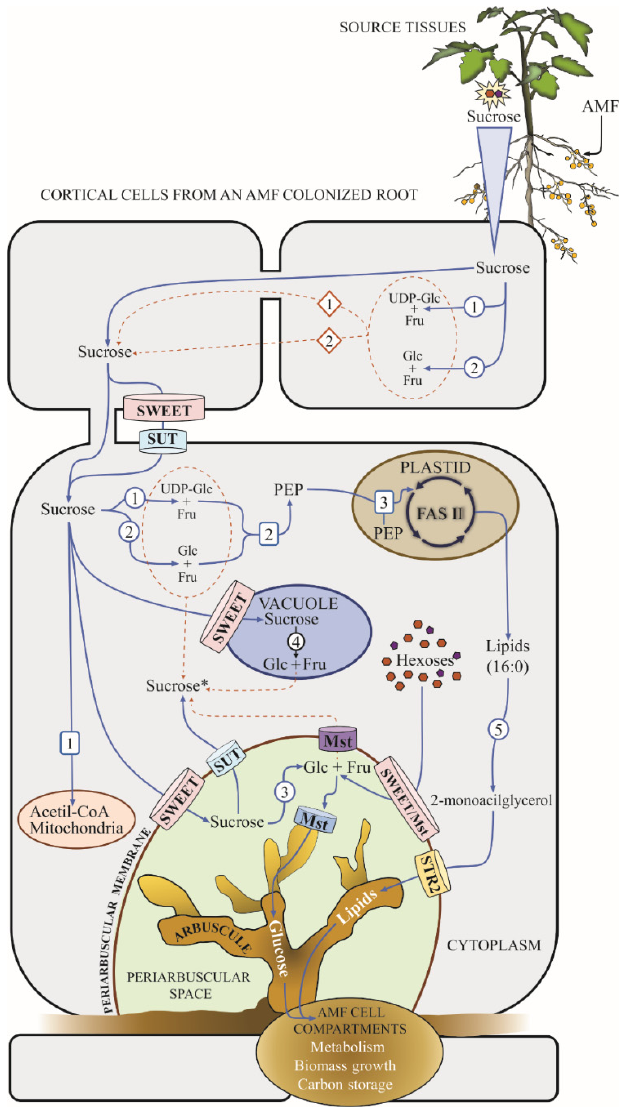
Figure 2. Carbon flux to the cortical root cells during arbuscular–mycorrhizal interactions. Photosynthates flow through the mycorrhizal plant from the leaves to the arbusculated cortical cells in the roots. The catabolism of Suc in the arbusculated and other cortical cells close to them promotes Suc mass flow and enables the translocation of hexoses, Suc, and lipids to the periarbuscular space towards the fungal arbuscule, imposing a carbon sink (Updated from Wipf et al., 2019; Roth and Paszkowski, 2017; and Manck-Götzenberger and Requena, 2016 [8,34,39]). Blue arrows trace the current carbon flow routes, the discontinued orange arrows showthe “futile” cycles of sucrose catabolism and synthesis, the colored barrels designate the carbohydrate transporters. Enzymes are indicated in numbered circles as: (1) Sucrose synthase; (2) Neutral invertase; (3) Apoplastic invertase; (4) Vacuolar invertase; (5) Glycerol-3-phosphate acyl transferase. Numbers in rounded rectangles denote specific metabolic pathways: (1) Suc as a source for aerobic respiration; (2) Glycolytic pathway to render phosphoenolpyruvate; (3) lipid synthesis mediated by the plastid Type I FAS molecular complex. Diamonds indicate potential carbon fluxes as: (1) symplastic and (2) apoplastic routes of hexoses entry to sink cells. Sucrose * indicates the sucrose biosynthesized in the arbusculated cell. 4. Sucrose Transporters and Sucrose Mobilization in Mycorrhizal Plants To achieve carbon loading in non-photosynthetic tissues, Suc synthesized in mesophyll cells reaches the apoplast adjacent to the phloem, where phloem loading is mediated by SUT [22]. The SUT proteins form a small three clade family divided into